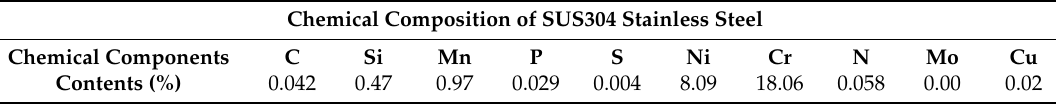
Table 1. Chemical composition of SUS304 stainless